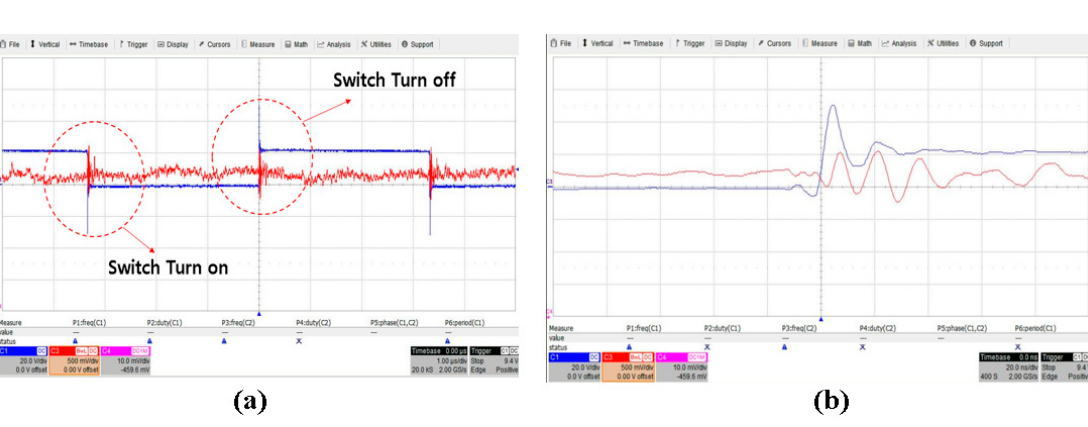
Figure 14. The drain-source voltage and current signals at the time of switching. ( a ) 1 cycle turn on-off waveform; ( b) A zoomed view.